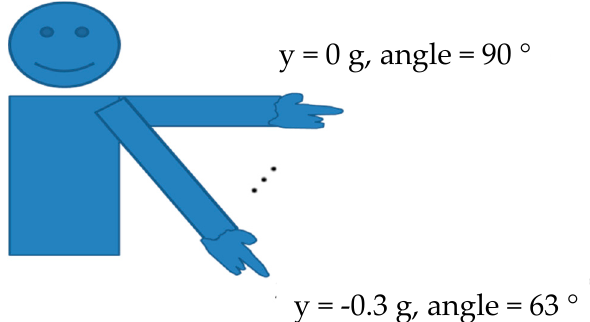
Figure 4. Schematic diagram of Equation(2).